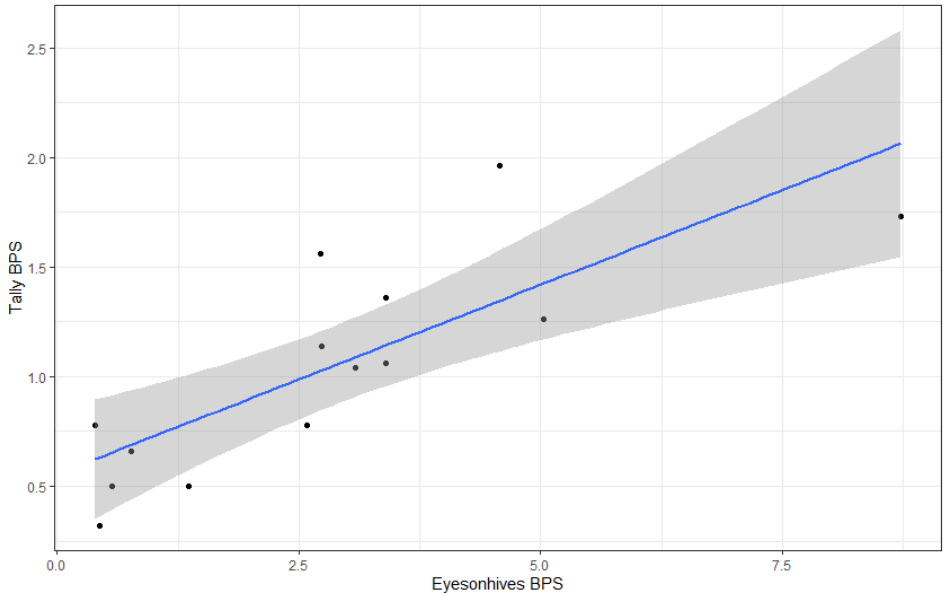
Figure 2. Linear regression for average bees per second (BPS) with 95% confidence interval indicated in grey represented with a tally counter (Y axis) compared against average BPS recorded by Eye- sonhives cameras (X axis) (tally BPS = 0.56 + 0.17 × Eyesonhives BPS). Table 1. Estimated regression parameters, standard errors, t -, and p -values for the Gaussian general- ized additive mixed model conducted to compare bee activity for hive strength (strong/weak) based on colony size and to compare a sugar syrup supplement treated with chlorine versus no chlorine as a factor. Smoothing terms included climate variables for temperature and windspeed for each level of the hive strength